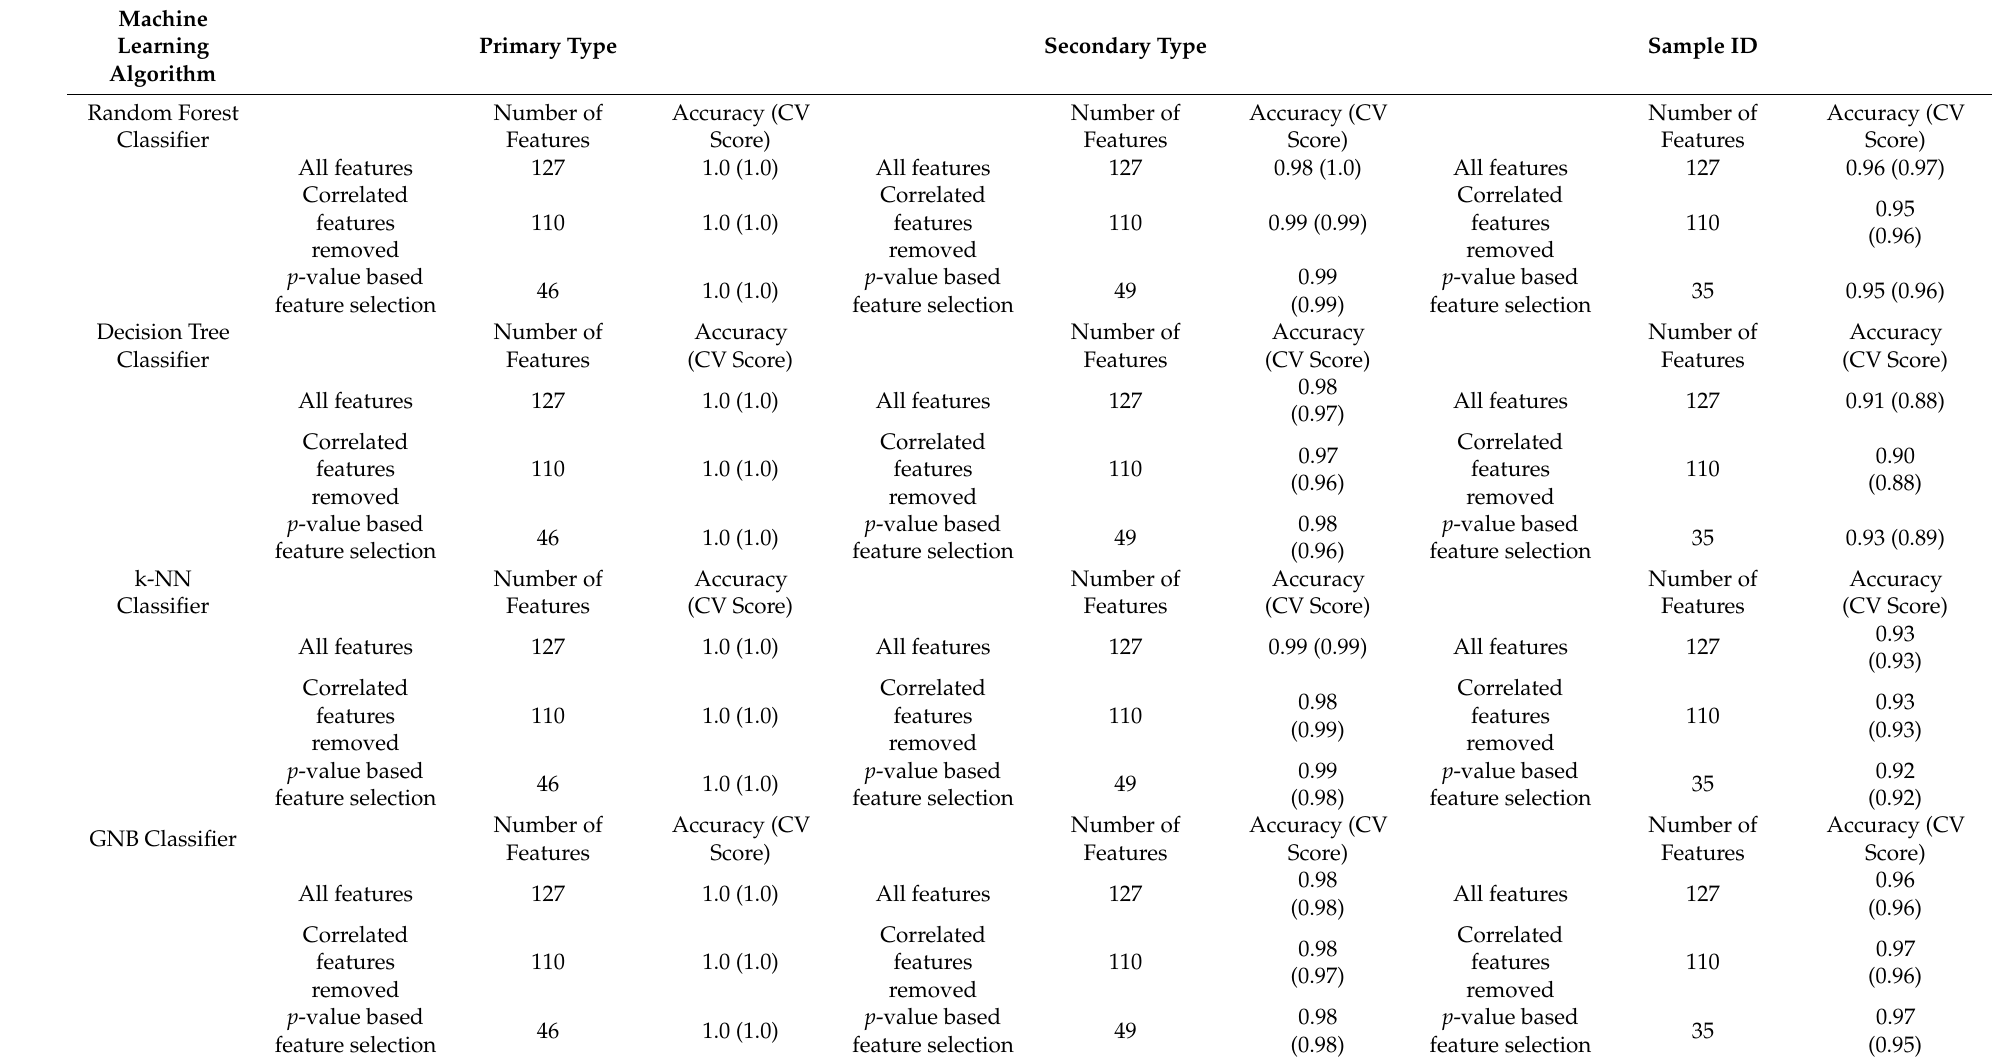
Table 4. Comparison of ML algorithms for prediction of primary type, secondary type, and Sample ID from py-MBMS spectral intensities after RUV correction of the